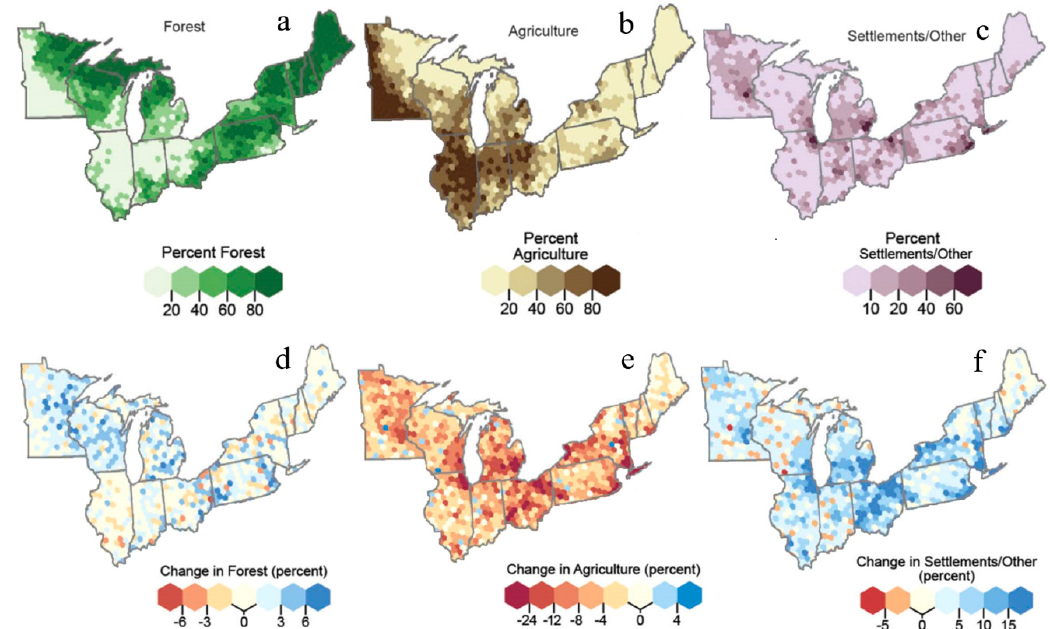
Figure 1. Location of study region across the Northern US.